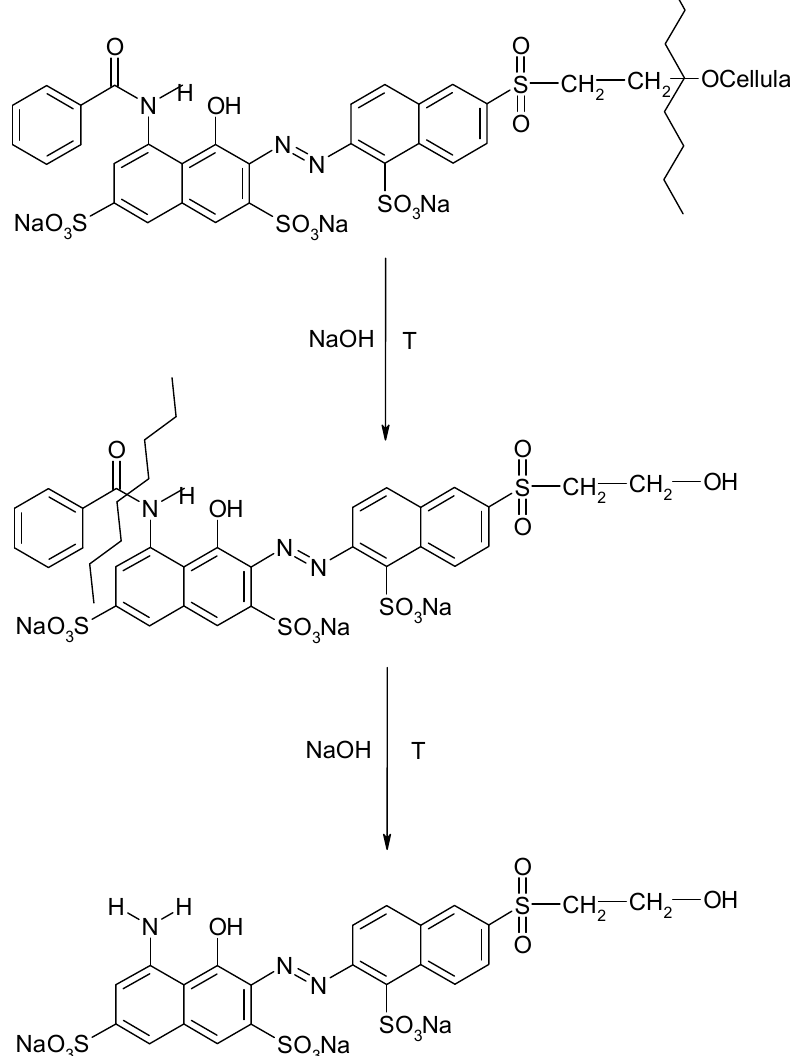
Figure 6. Mechanism of the extraction of Reactive Red 180 from cellulose, involving dye hydrolysis due to excess NaOH.